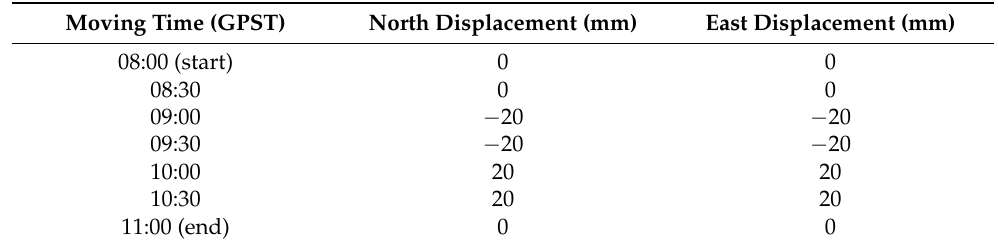
Table 9. Schedule of simulated deformation.